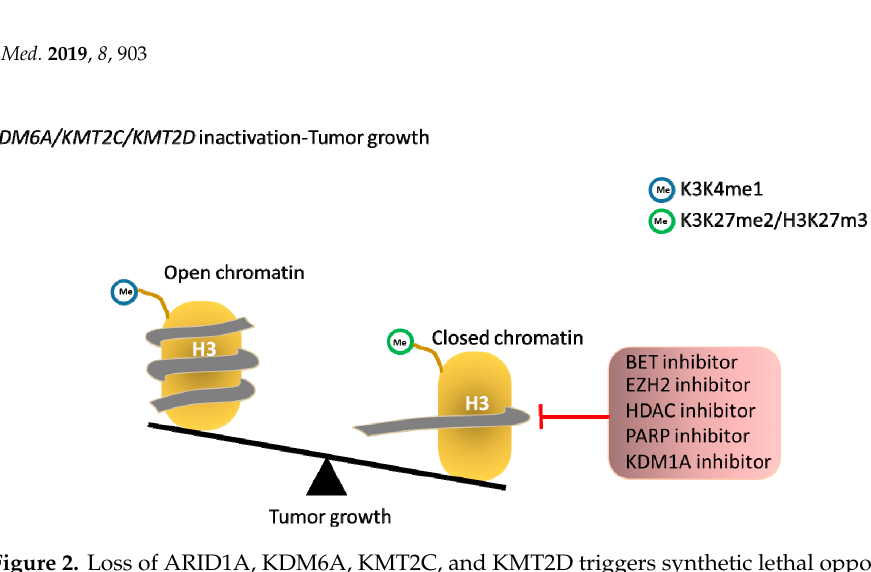
Figure 2. Loss of ARID1A, KDM6A, KMT2C, and KMT2D triggers synthetic lethal opportunities for cancer treatment. ( A ) ARID1A is a member of the SWI / SNF chromatin-remodeling complex that regulates transcription and nucleosome condensation. The blockage of specific oncogenic pathways was defined as a potential strategy in ARID1A-deficient cells. ( B ) KDM6A and KMT2C / KMT2D represent lysine demethylase and methyltransferase, respectively. The inactivation of KDM6A, KMT2C, and KMT2D is associated with a closed chromatin structure that is specifically sensitized by the indicated inhibitors.